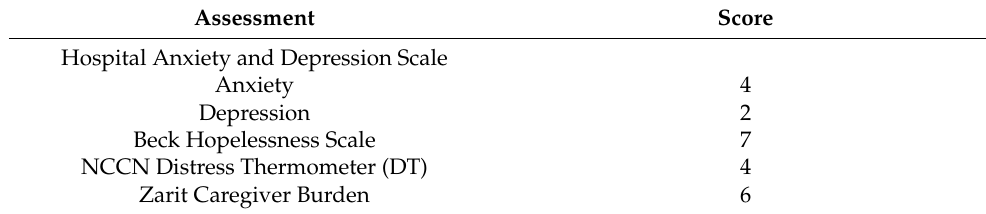
Table 1. Caregiver psychosocial